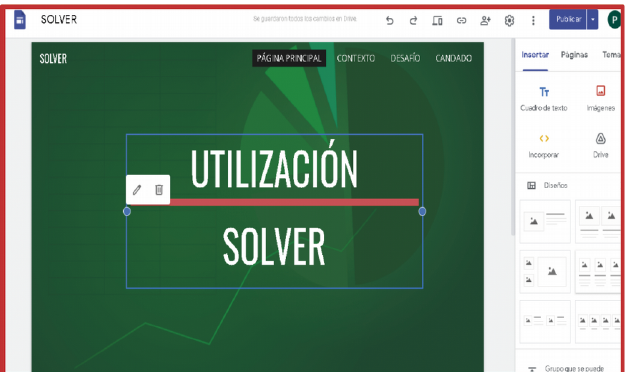
Figure 8. Scape Room of the use of Operations Research and Solver: https://bit.ly/3IwHcm6